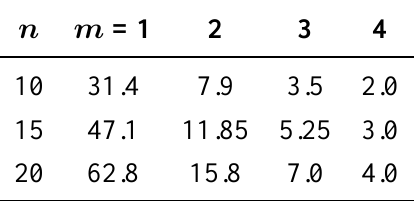
Table 1. n · A ER for various values of m and n A G